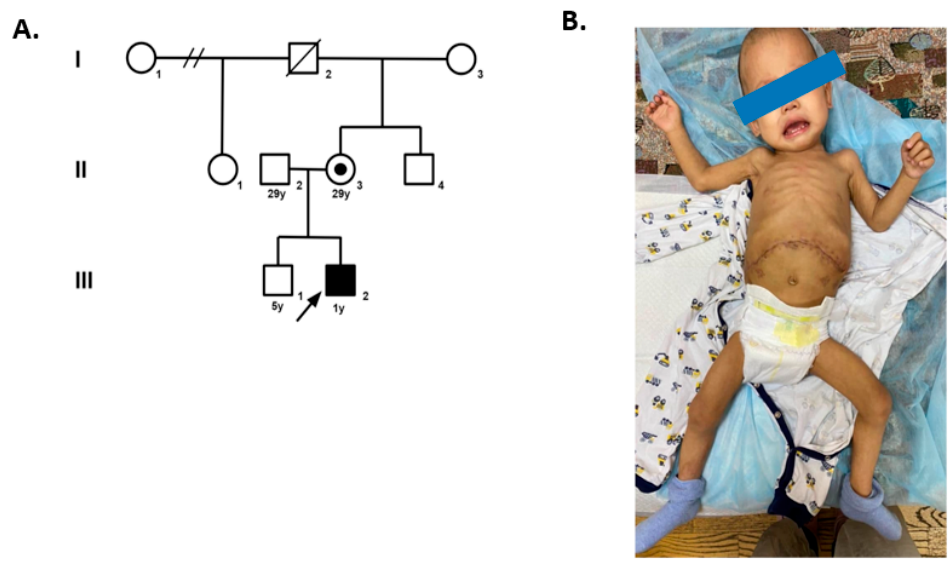
Figure 1. Pedigree chart of the patient ( A ) and patient’s general appearance at the age of 1 year ( B ).